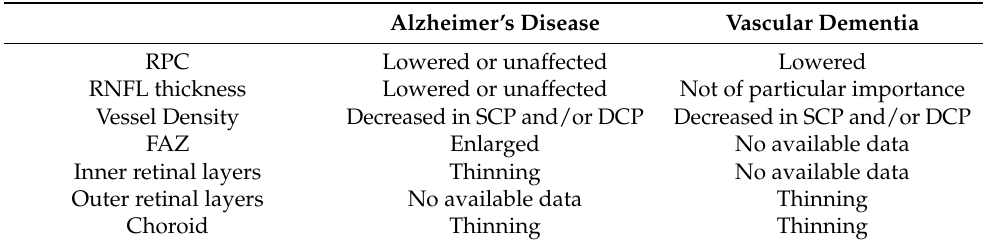
Table 1. Suggested Alzheimer’s disease and vascular dementia OCT/OCTA biomarkers. Alzheimer’s Disease Vascular Dementia RPC Lowered or unaffected Lowered RNFL thickness Lowered or unaffected Not of particular importance Vessel Density Decreased in SCP and/or DCP Decreased in SCP and/or DCP FAZ Enlarged No available data Inner retinal layers Thinning No available data Outer retinal layers No available data Thinning Choroid Thinning Thinning RPC: radial peripapillary capillary; RNFL: retinal nerve fiber layer; SCP: superficial capillary plexus; DCP: deep capillary plexus; FAZ: foveal avascular